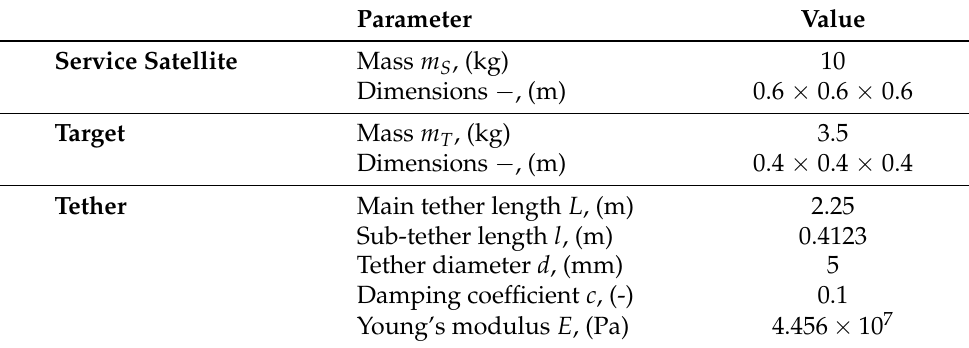
Table 1. Simulation Parameters.